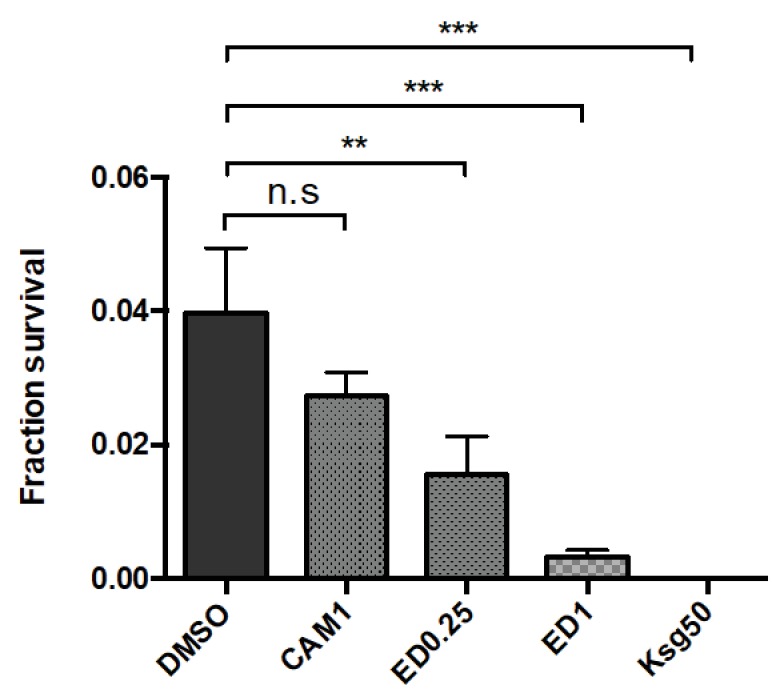
The initiation inhibitors edeine and kasugamycin decrease Msm rifampicin plate tolerance.Cells were plated on rifampicin-agar (25 µg/ml) ±DMSO or other antibiotics as shown (edeine, ED 0.25–1 µM, chloramphenicol, CAM 1 µg/ml and kasugamycin, Ksg, 50 µg/ml). The translation inhibitors at the concentration used did not affect plating efficiency when used as a solitary agent. Survival fraction (compared with no antibiotic) was measured after 5–6 days. **p<0.01, ***p<0.001, n.s. no significant difference by Student’s t-test.